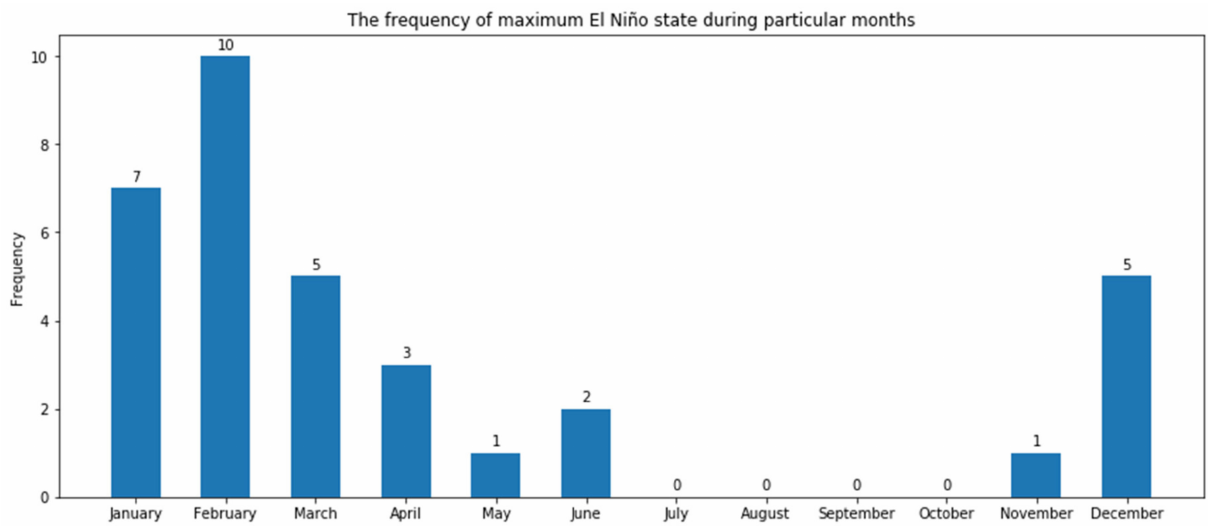
Figure 7. Occurrence of the maximum value of an anomaly during El Niño episodes. Data from Table S1 and Figure